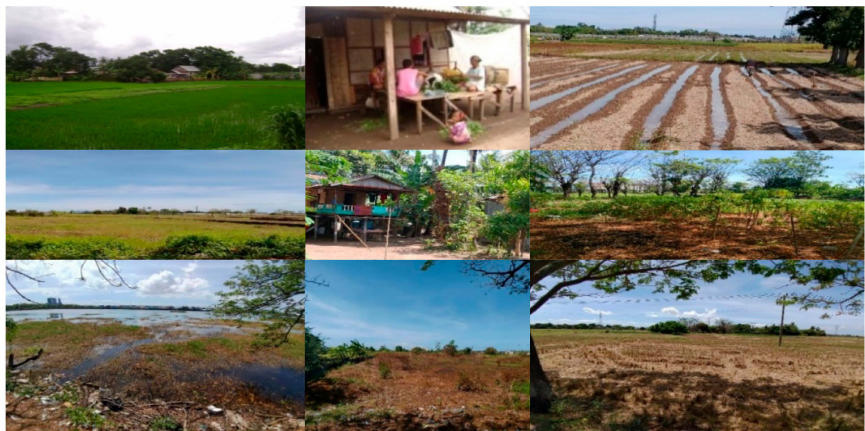
Figure 4. The main activities of local communities in the agricultural sector in the period 2006–2008. Source: Primary data.